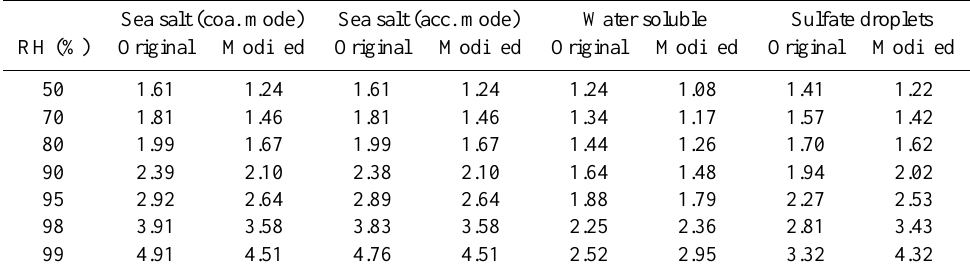
Table 4. Original and modified hygroscopic growth factor g (RH) of the RH-dependent OPAC components (Hess et al., 1998). The modified values of g (RH) for the sea salt component were taken from Swietlicki et al. (2008), those for the water soluble from Zieger et al. (2011) and those for the sulfate component from Topping et al. (2005). The modified values were calculated for the corresponding relative humidities (RH) using Eq. (3). See text and Fig. 11 for more details. Sea salt (coa. mode) Sea salt (acc. mode) Water soluble Sulfate droplets RH (%) Original Modified Original Modified Original Modified Original Modified 50